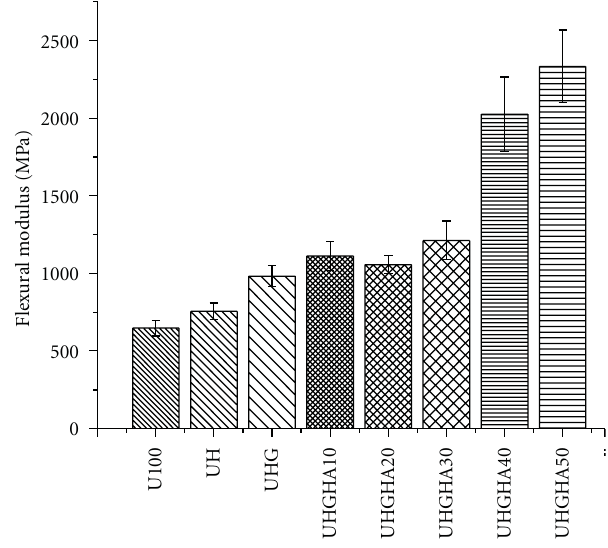
Figure 7: Flexural modulus of UHMWPE/HDPE, UHMWPE/ HDPE/PEG blends, and UHMWPE/HDPE/PEG/HA composites.